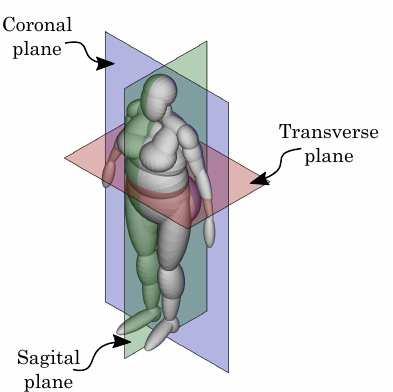
Figure 10. Anatomical planes defined for the Reference Mannequins.